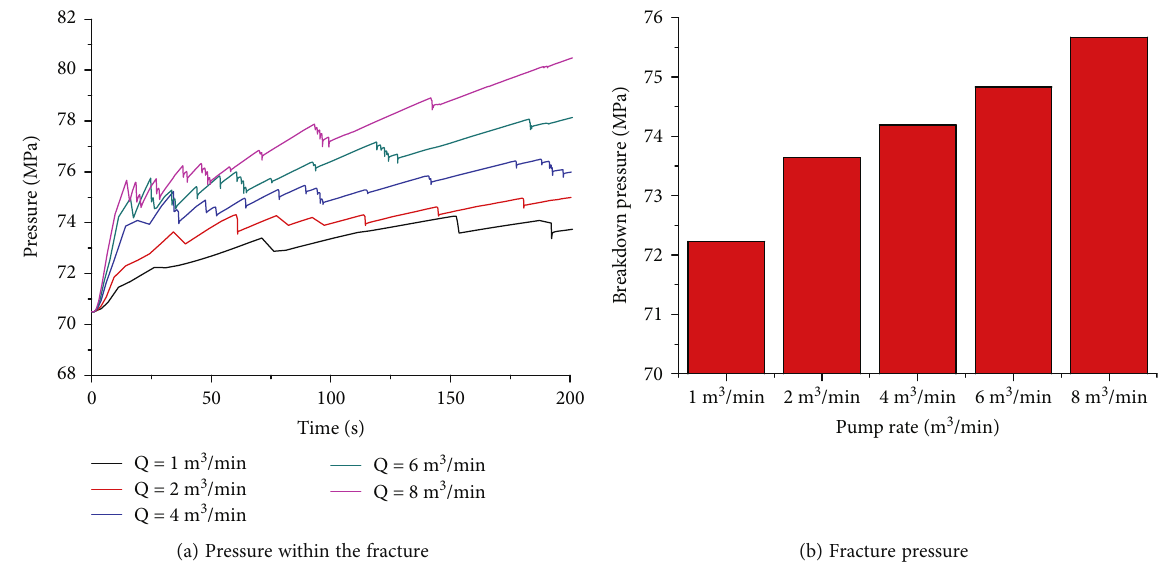
Figure 17: Pressure within the fracture and fracture pressure at the NF approaching angle of 30 ° and at injection rates from 1-8 m 3